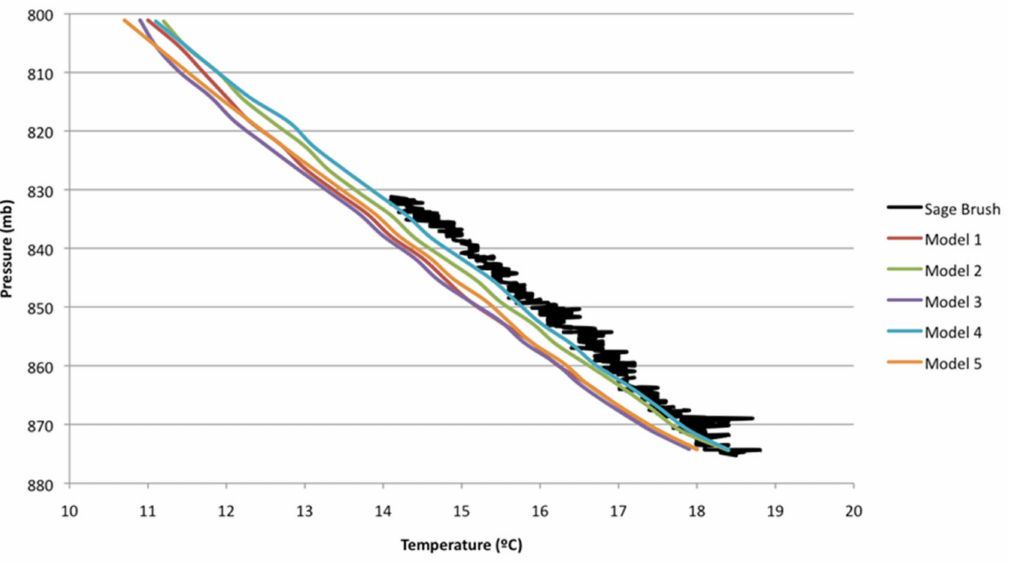
Figure 20. Model upper-air temperature profile ( ◦ C) shown by pressure level (hPa) for different model experiments vs. tethersonde at 2200 UTC 10-14-2012 at the Sagebrush (off-playa)